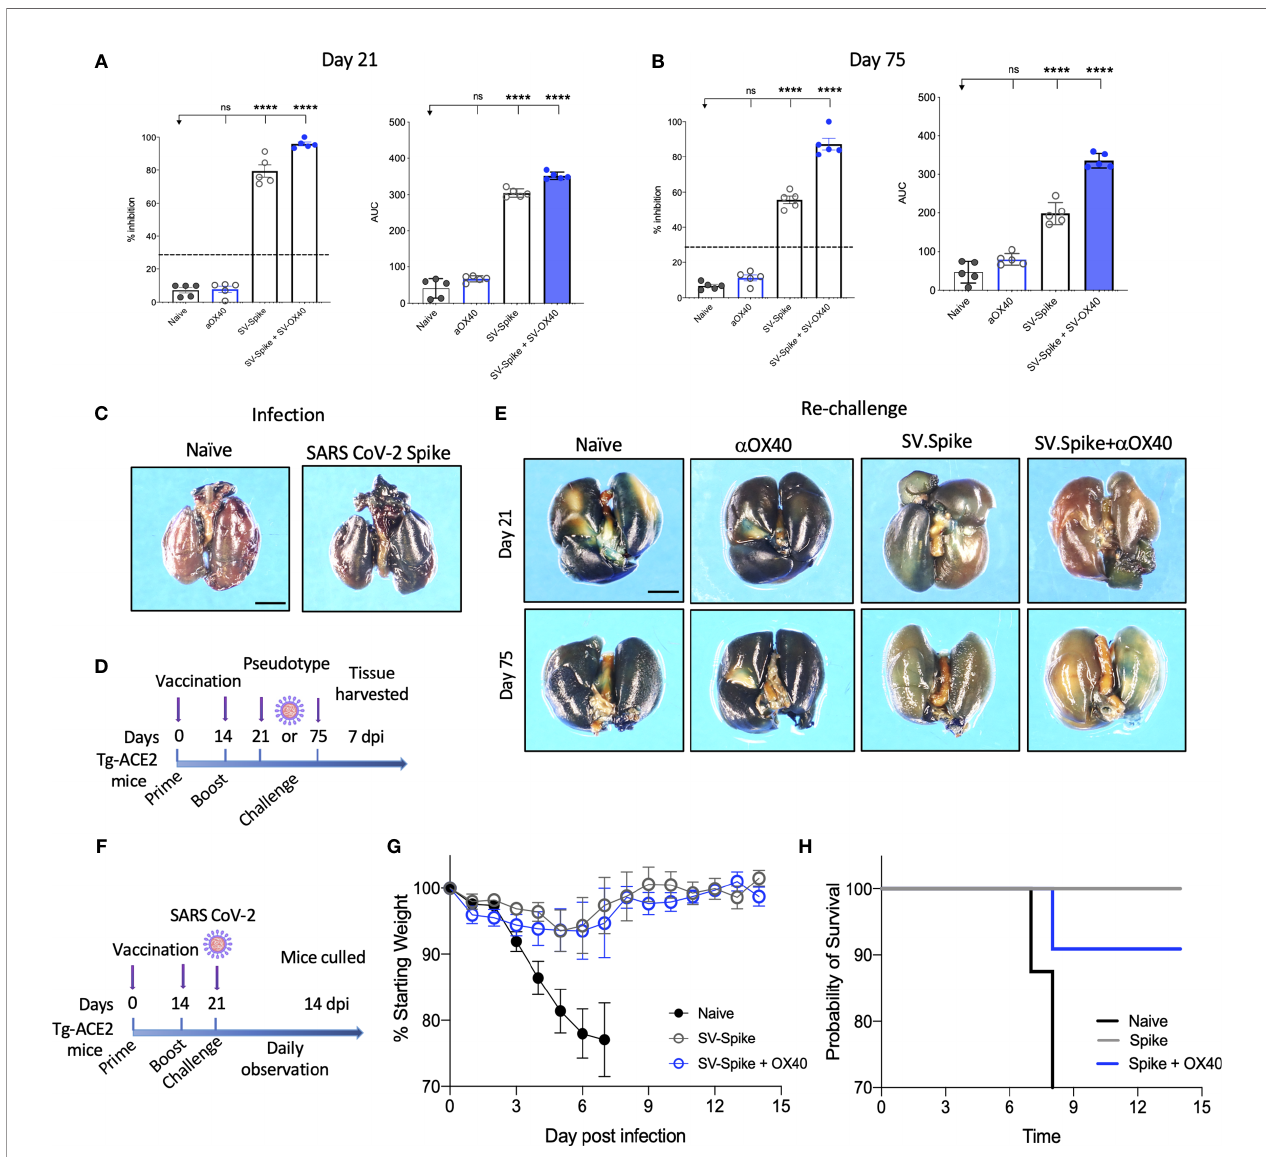
FIGURE 4 | Sindbis-Spike vaccine prevents infection of SARS-CoV-2 in hACE2 transgenic (hACE2-Tg) mice. Luciferase -encoding SARS-CoV-2 spike pseudotyped lentivirus was incubated with mouse sera collected at (A) 21 and (B) 75 days post vaccination with SV.Spike, SV.Spike in combination with a OX40 and a OX40 antibody alone compared and unvaccinated naïve groups. Area under the curve (AUC) values of serum antibodies were calculated from reciprocal dilution curves in antibody detection assay. The data presented are the mean of 5 biological replicates with two technical replicates. Statistics were performed using a One-way ANOVA with the Bonferroni correction in GraphPad Prism. n.s. > 0.05; ****P<0.0001. (C) Expression of pseudotyped SARS-CoV-2-spike-lacZ lentivirus in whole mouse lung following intranasal delivery. One week following vector nasal administration to the right nostril of four weeks old hACE2 transgenic and control mice (B6 (Cg)-Tg(K18-ACE2)2Prlmn/J), expression of LacZ was analyzed in mice airways. X-Gal stained whole lungs from (left) hACE2 non carrier control mouse and (right) hACE2 transgenic mouse, both dosed with SARS-CoV-2-spike-lacZ pseudotyped lentivirus. (D) Schematic of the “ challenge ” experiment with SARS-CoV-2-spike- lacZ lentivirus. (E) On day 21 (upper panels) and 75 (lower panels) after the initial infection hACE2-Tg were “ challenged ” with 3.6 x 10 5 PFU of SARS-CoV-2-spike- lacZ pseudotyped lentivirus and then analyzed for X-Gal staining at day 7 “ post-challenge. ” Three non-vaccinated naïve animals were included as a positive control in the “ challenge ” experiment. (F – H) hACE2-Tg mice were vaccinated with SV.Spike and/or a OX40 and challenged with 10 4 particles of live SARS-CoV-2 coronavirus at day 21 post immunization. Weight loss and mortality were observed daily for 14 days after live virus infection and compared to the naïve unvaccinated group. (G) Change of body weight during systemic infection with SARS-CoV-2 coronavirus. Percent weight loss (y-axis) is plotted versus time (x-axis). Data points represent mean weight change +/ − SEM. (H) Survival curves of SV.Spike with or without a OX40 treated and naïve unvaccinated mice. n=4 or 5 mice per group. One mouse belonging to the SV.Spike+aOX40 group died for inapparent reasons 7 days after challenge with the authentic SARS-CoV_2. Graph points in (G) were calculated as average of 4 mice instead of